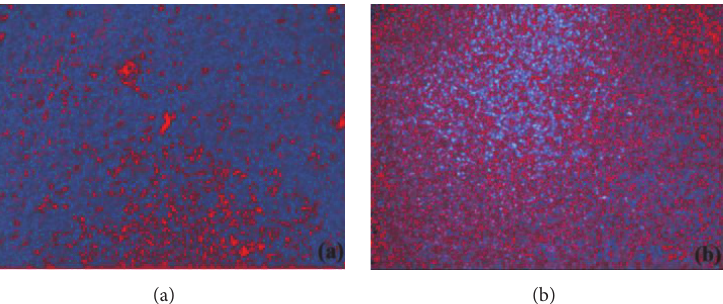
Figure 5: Optical images showing the porosity in D-Gun sprayed (a) WC-12% Co; (b) Cr 3 C 2 -25% NiCr coating on an ASTM A36 steel